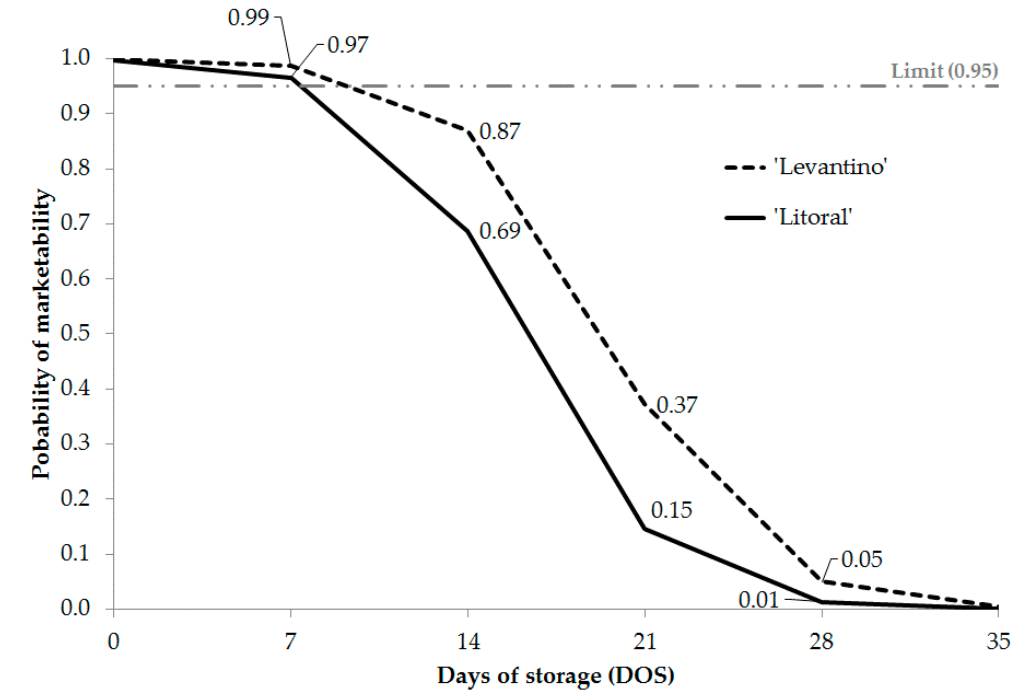
Figure 5. Timeline of the probability of marketability as a function of the days of storage (DOS) for the Levantino and Litoral cucumber cultivars.